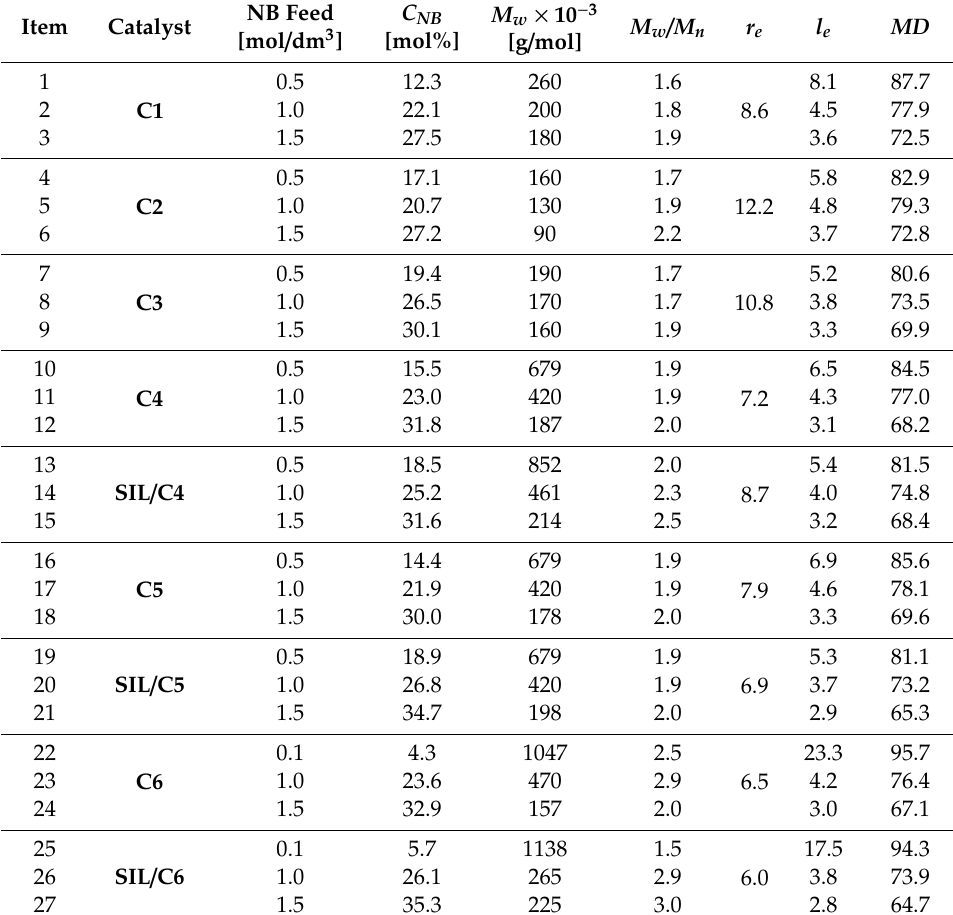
Table 1. Selected parameters of E-NB copolymers and copolymerization reaction performed using studied vanadium